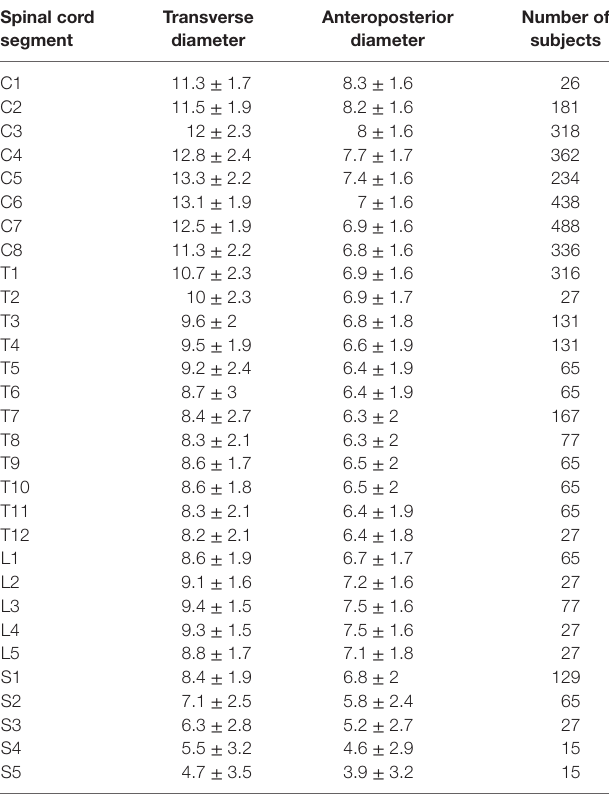
TaBle 1 | Estimated spinal cord diameters from Frostell et al. 2016 used as a spinal cord segments by using three different ellipses with a basis for simulation in the current study. spinal cord Transverse anteroposterior number of segment diameter diameter subjects